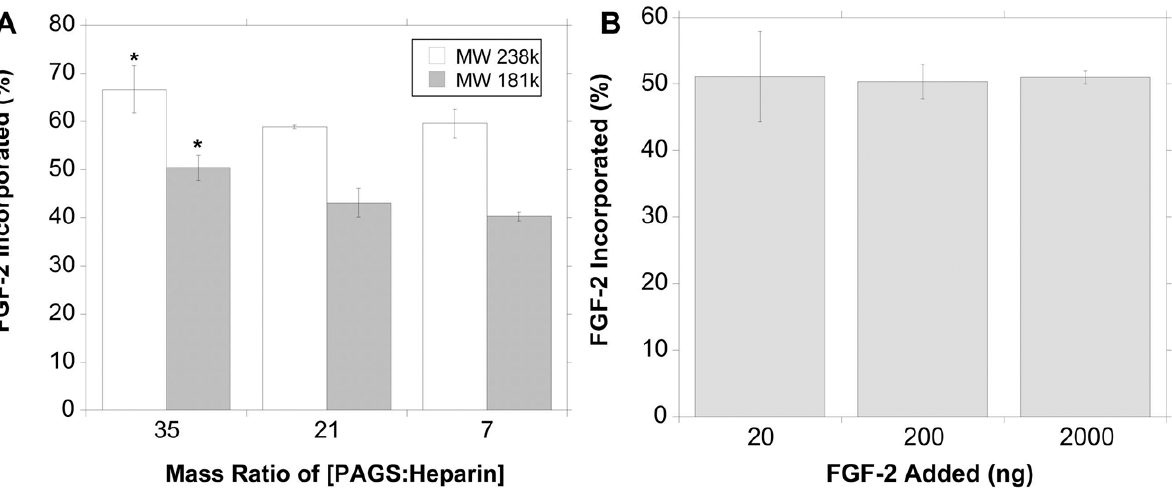
Figure 3. Complex loading efficiency and capacity was investigated using 125 I-FGF-2. [A] Loading efficiencies of different molecular weight PAGS was investigated for different [PAGS:heparin] ratios. The higher molecular weight PAGS was more efficient at incorporating FGF-2 at all [PAGS:heparin] ratios than the lower molecular weight polymer. A ratio of [35:1] was the most efficient at incorporating FGF-2 for both molecular weight species. [B] The loading capacity of complexes was investigated for a [35:1] ratio of low molecular weight PAGS. This ratio demonstrated a loading efficiency of 50% for all amounts of FGF-2. Statistical significance between [35:1] and other ratios was noted as ‘‘*’’, p , 0.05.